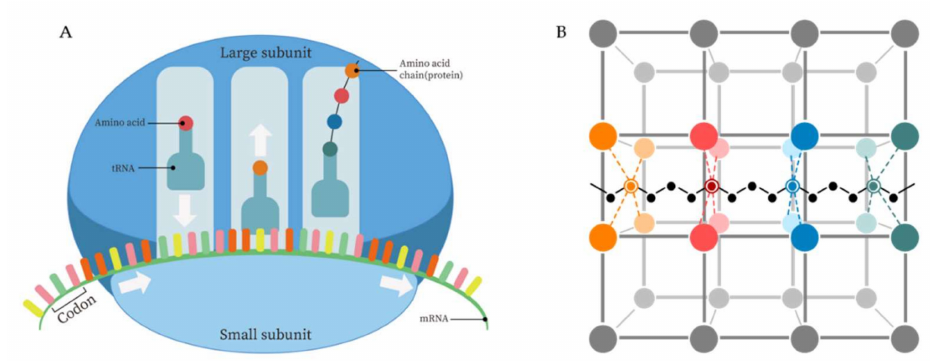
Figure 20. ( A ) The schematic representation of the mechanism for ribosome-catalyzed sequence-specific polymerization of amino acids. ( B ) An outlook of the challenging goal of MOF-templated sequence-specific polymerization using multivariate